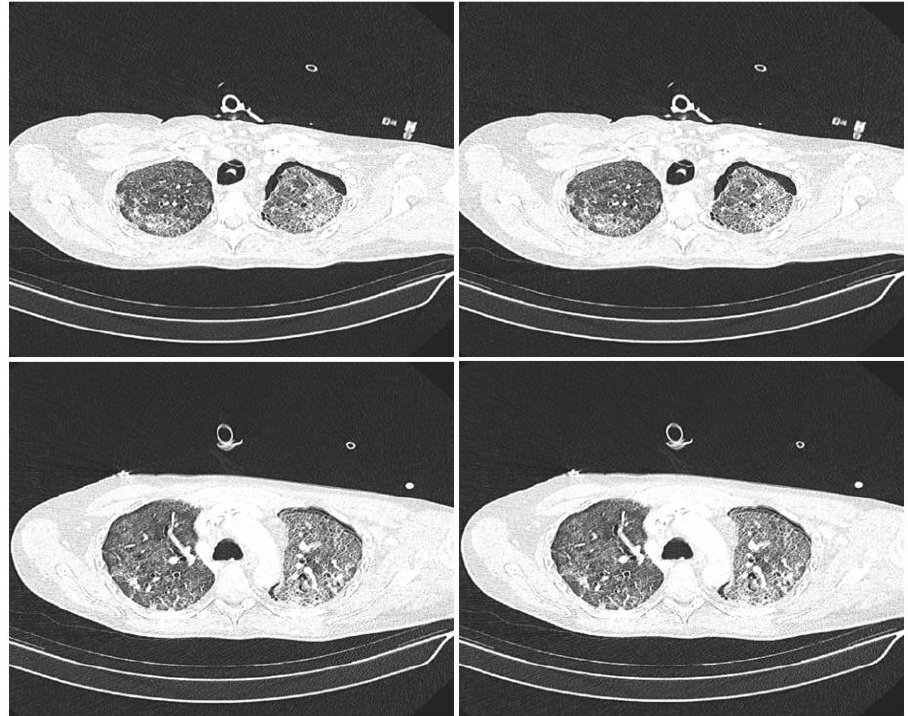
Figure 3. Lung computed tomography scans after the segmental lung recruitment CT scans showing different sections of lung: apical lung ( top left picture), middle part of the lung ( top right and bottom left picture) and basal lung ( bottom right picture).